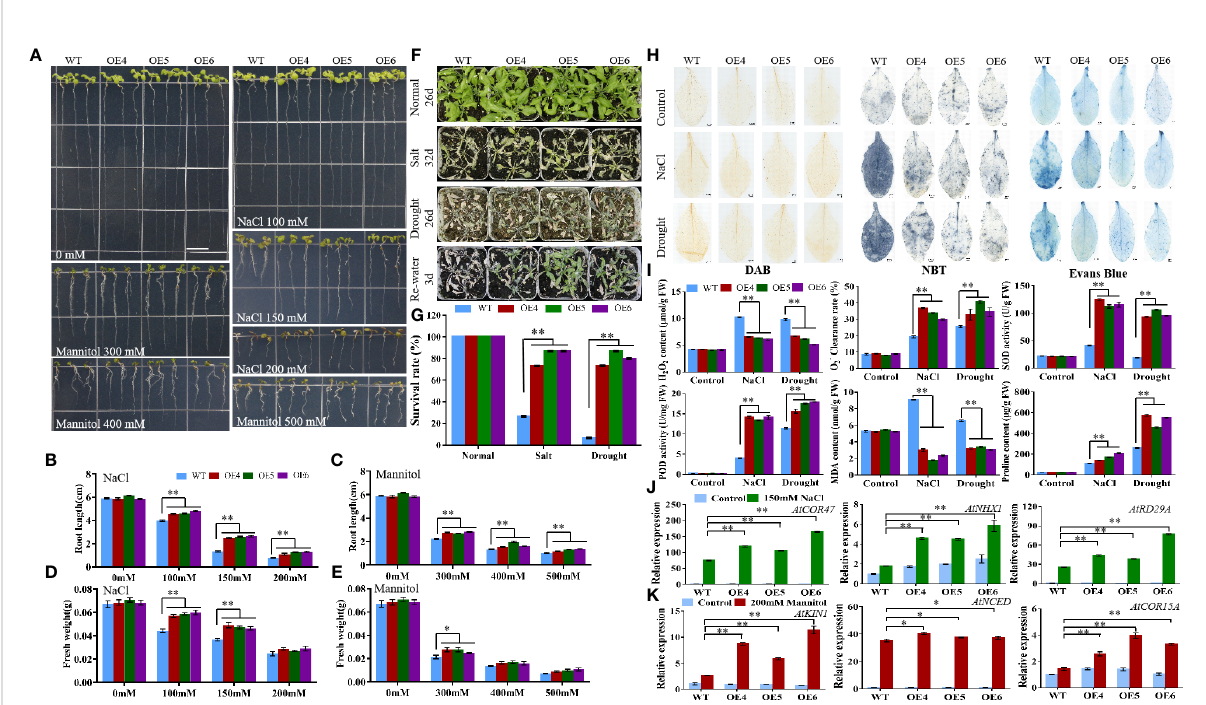
FIGURE 10 Analysis of MiCOL9B transgenic lines and WT under different stress treatments. (A) Phenotype. The bars represent 1.0 cm. (B, C) Root length and (D, E) fresh weight under NaCl and mannitol conditions. (F) Phenotypes. Normal, control; salt, 300 mM NaCl; drought, withholding of water. (G) Survival rate. (H) DAB, NBT and Evans Blue staining. (I) H 2 O 2 content, O − 2 clearance rate, SOD activity, POD activity, MDA content and proline content. (J, K) Expression pattern of stress-related genes. Blue, before treatment; green, 150 mM NaCl (J) ; red, 200 mM mannitol (K) . Signi fi cant differences were assessed at p < 0.05 (*) and p < 0.01 (**) levels by Student ’ s t